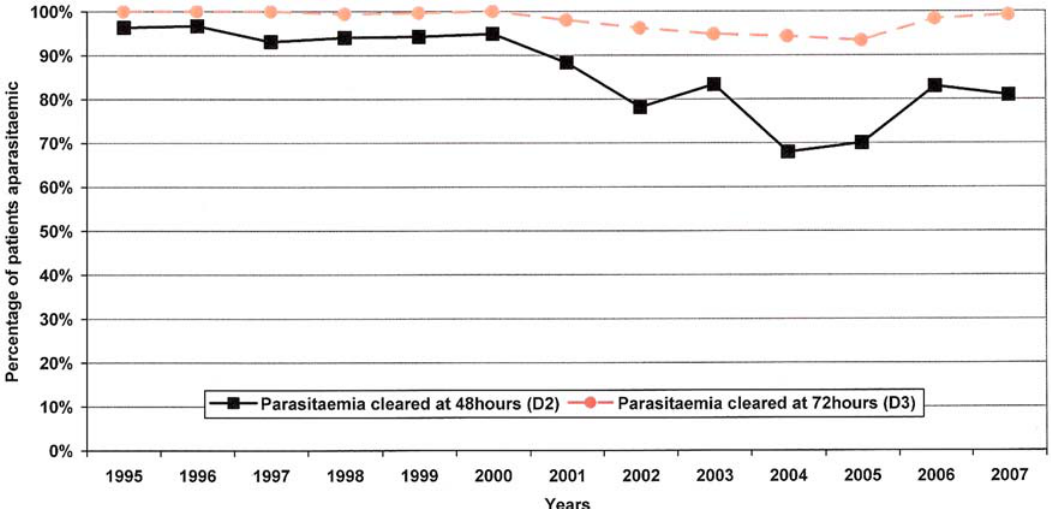
Figure 1. Percentage of patients who had cleared parasitaemia at Day-2 and Day-3 1995–2007. doi:10.1371/journal.pone.0004551.g001 PLoS ONE |